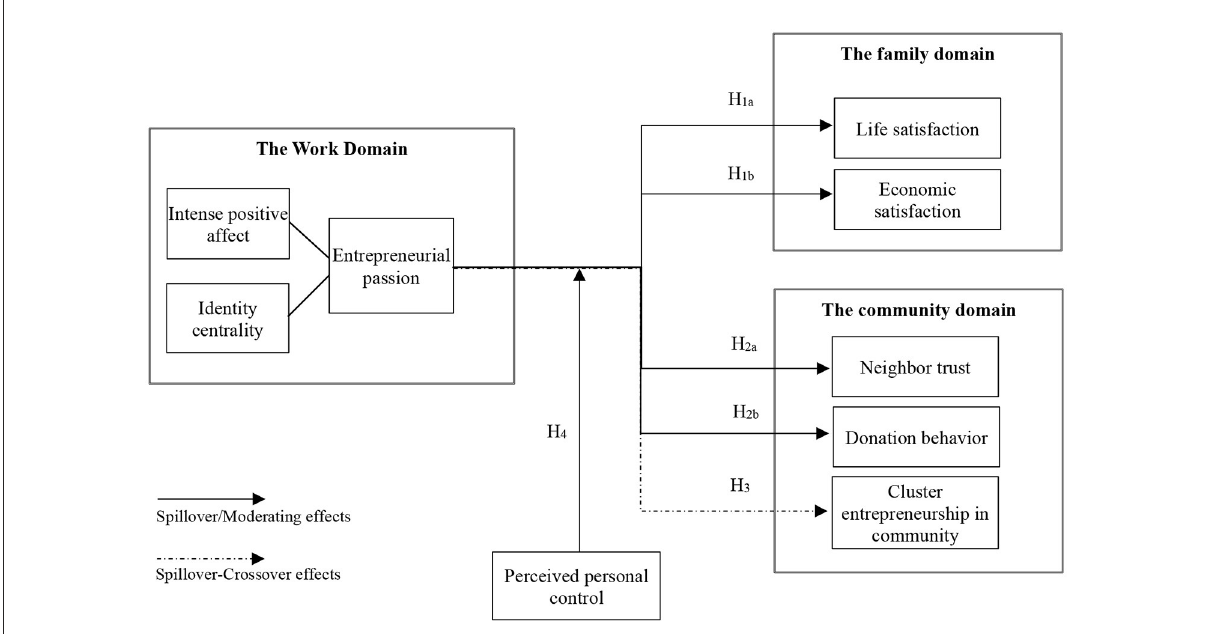
FIGURE1 The theoretical model of entrepreneurial passion spillover